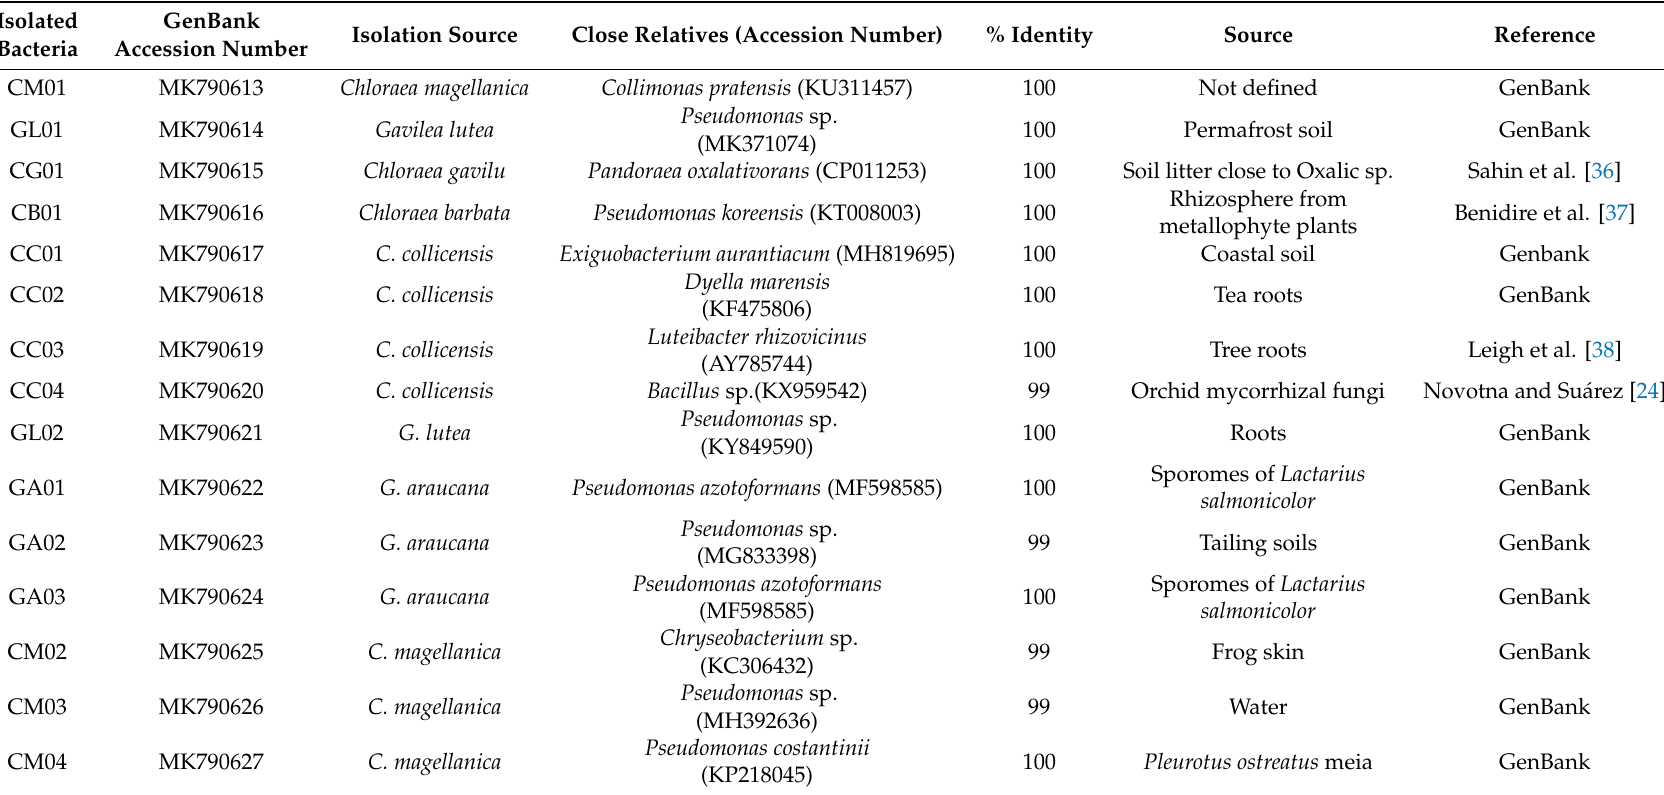
Table 2. Molecular identification of culturable bacteria isolated from peloton-containing root segments based on the closest match in the GenBank database.